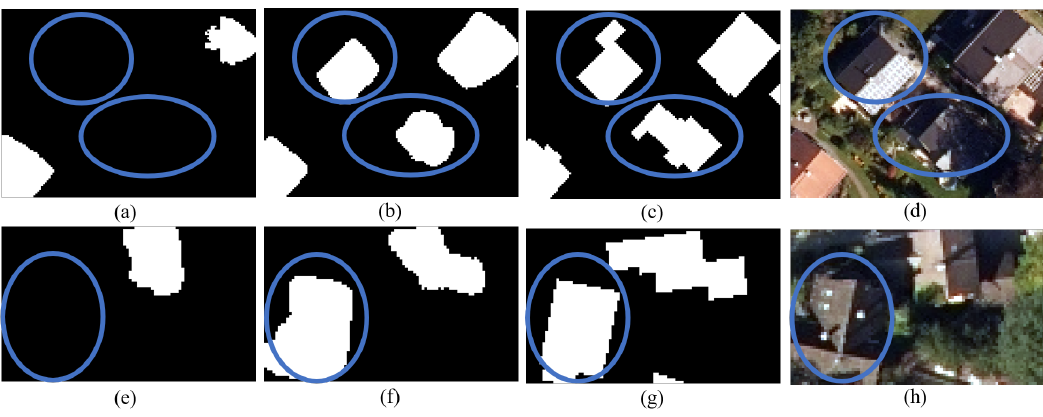
Figure 6. The new undocumented buildings in Ansbach obtained from (a), (e) Trained model 1, (b), (f) Trained model 2, and their corresponding (c), (g) DFK as well as (d), (h) TrueDOP.